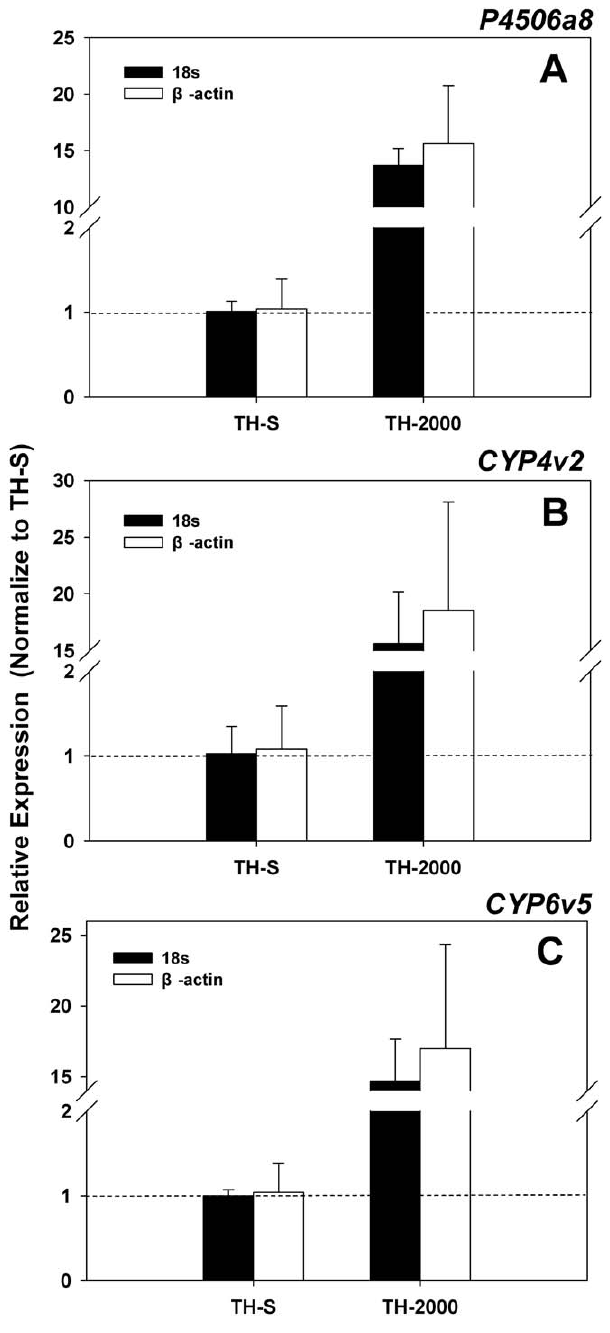
Figure 6. Gene expression profiling of putative P450s in thiamethoxam resistant and susceptible B. tabaci . mRNA expression levels of P4506a8 (A), CYP4v2 (B), and CYP6v5 (C) in thiamethoxam resistant (TH-2000) and susceptible ( TH-S) B. tabaci were analyzed by the qRT-PCR. Relative gene expressions in the resistant TH-2000 population were normalized to the susceptible TH-S population using both 18s rRNA and b -actin as the internal references. Standard errors were generated from the three biological